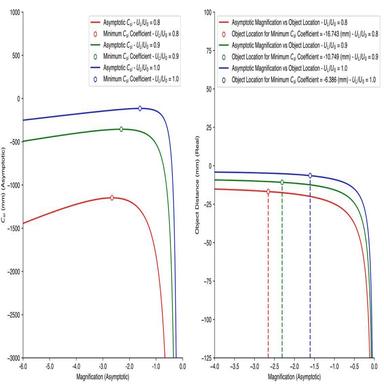
Left panel plots Csi as a function of asymptotic magnification for three different values of Ul/U0, calculated via The circular dot denotes the magnification that gives the smallest Csi. The right panel plots asymptotic magnification vs real object location. Again the circular dot corresponds to the asymptotic magnification (and thus real object location) that gives the smallest values of Csi.